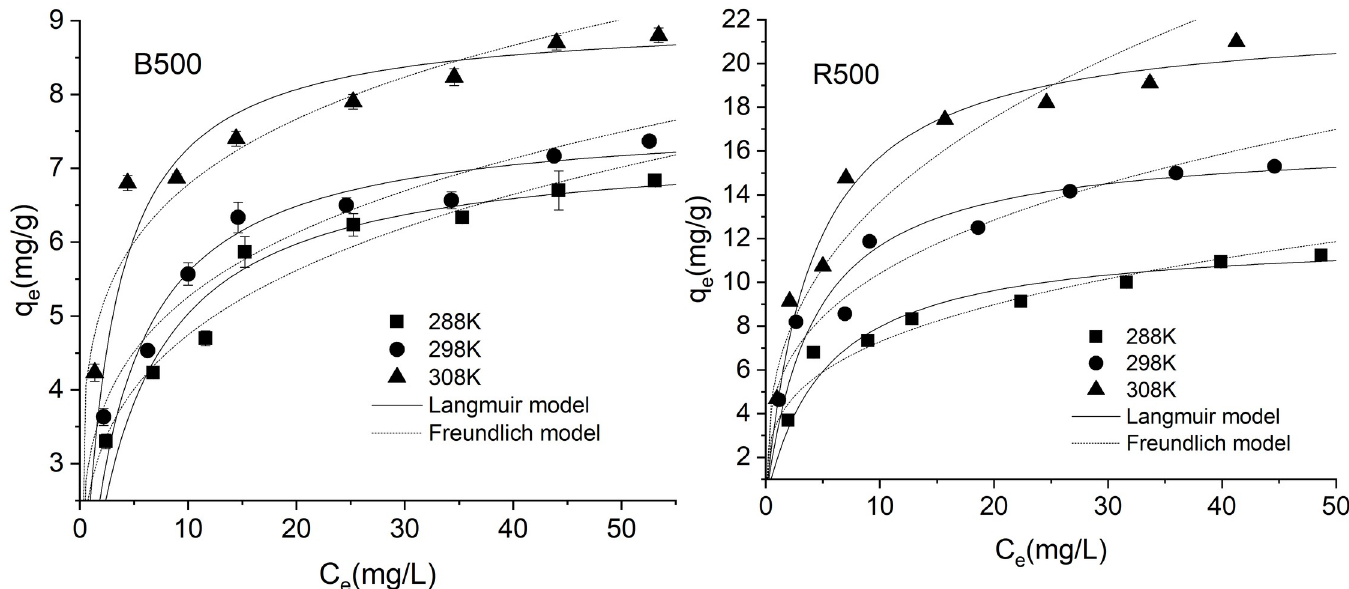
Fig 6. Adsorption isotherms for the adsorption of BR46 on B500 and R500 (pH = 7.0).